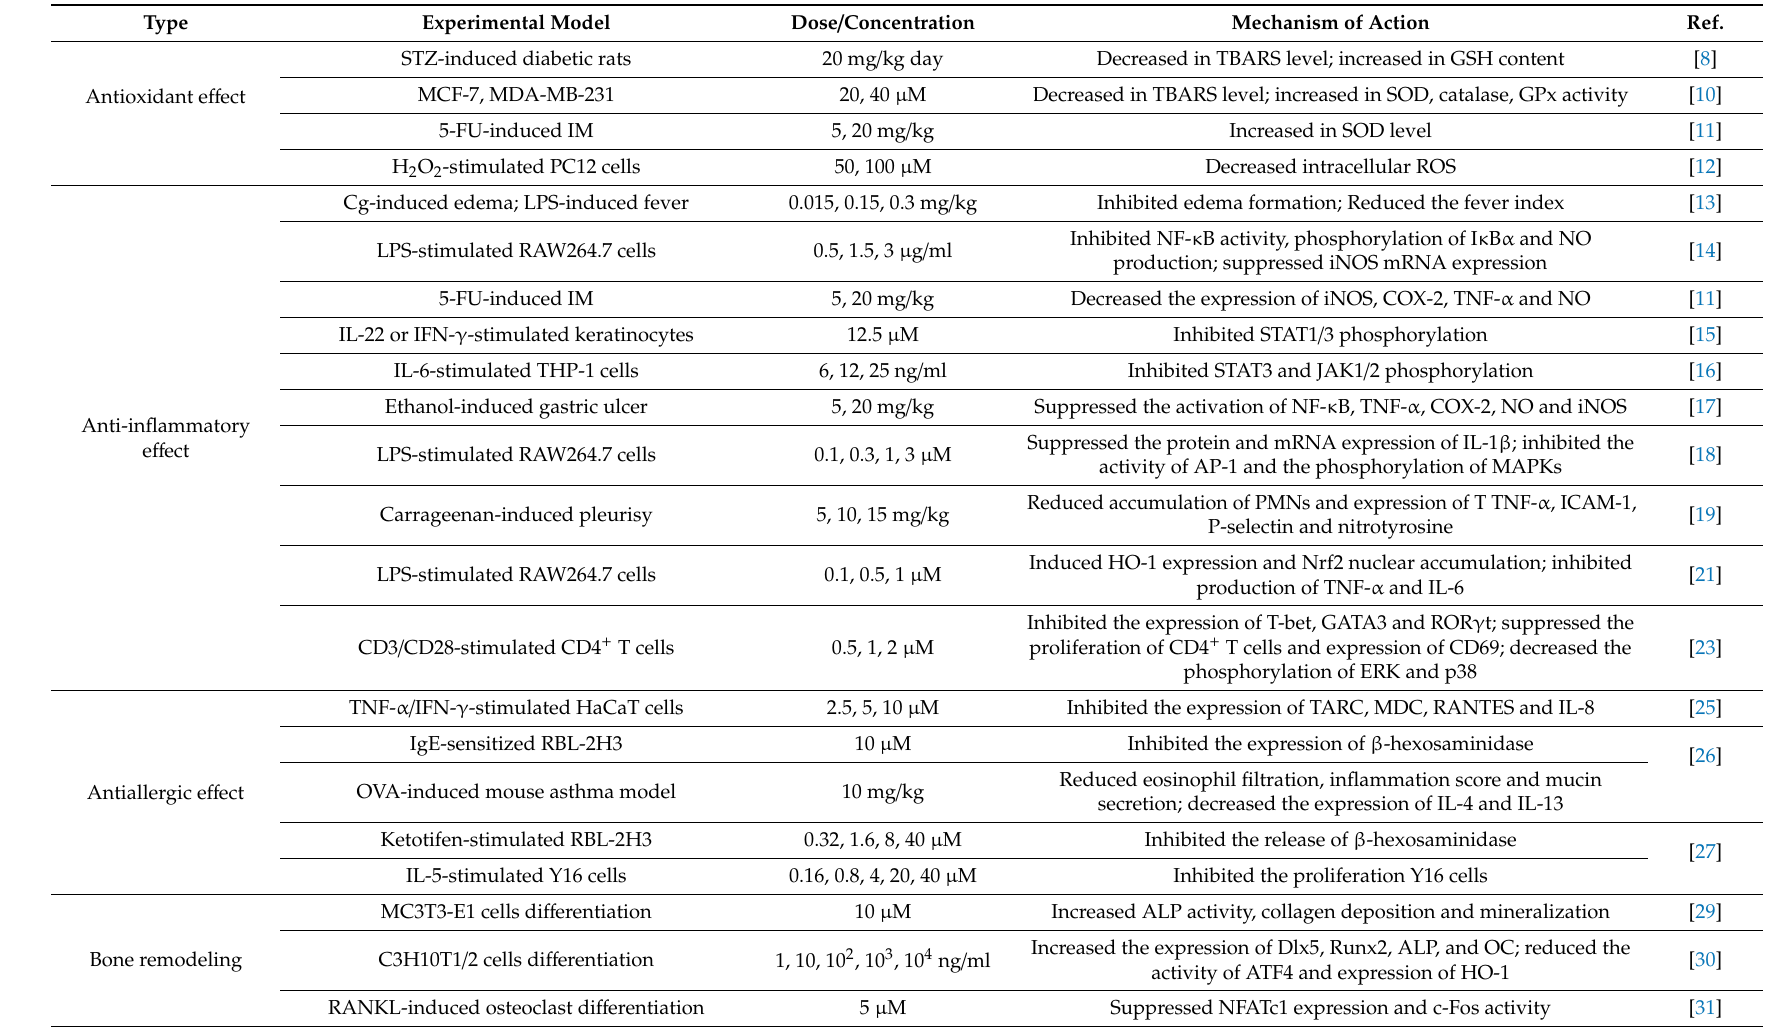
Table 2. Molecular mechanisms underlying bioactivities of